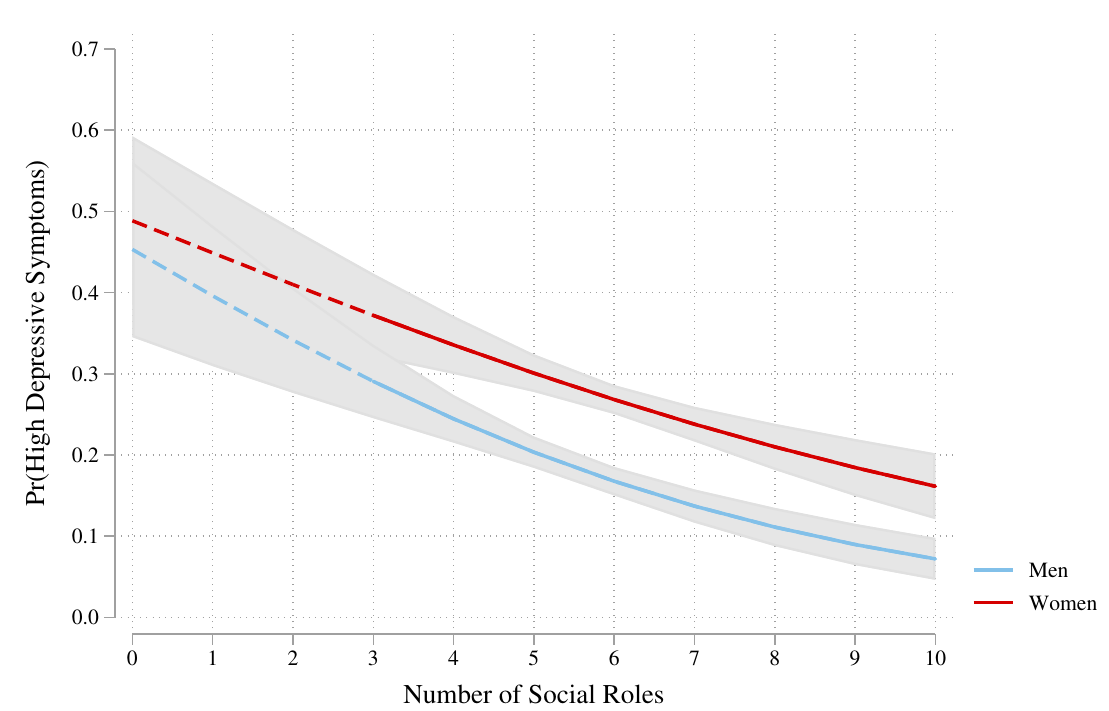
Figure 14: Predicted probability of high depressive symptoms by gender and social roles held: interaction effect between gender and social